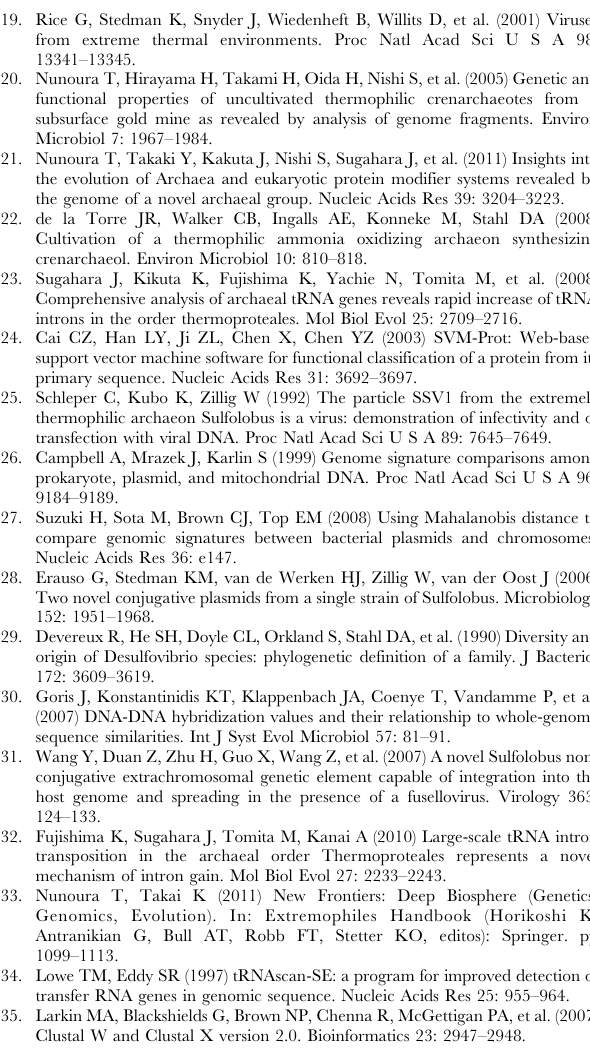
Table S2 Summary of d *-values for 180 archaeal chromosomes and plasmids. a Plasmids encoding pNOB8- type integrases are